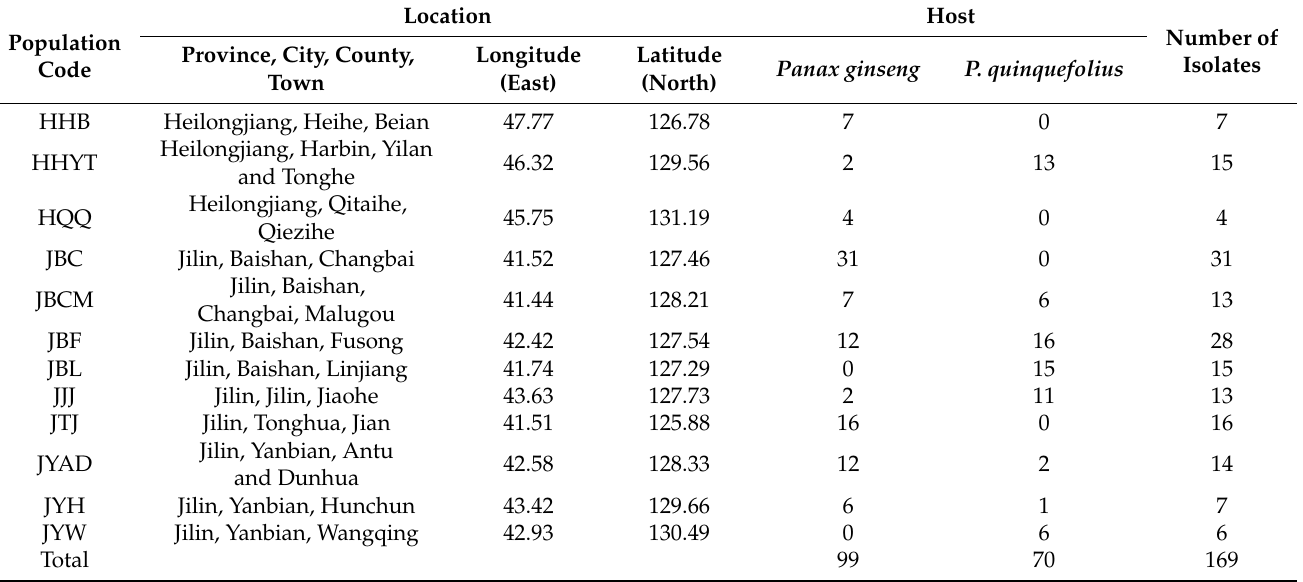
Table 1. Cylindrocarpon -like fungal populations analyzed in this